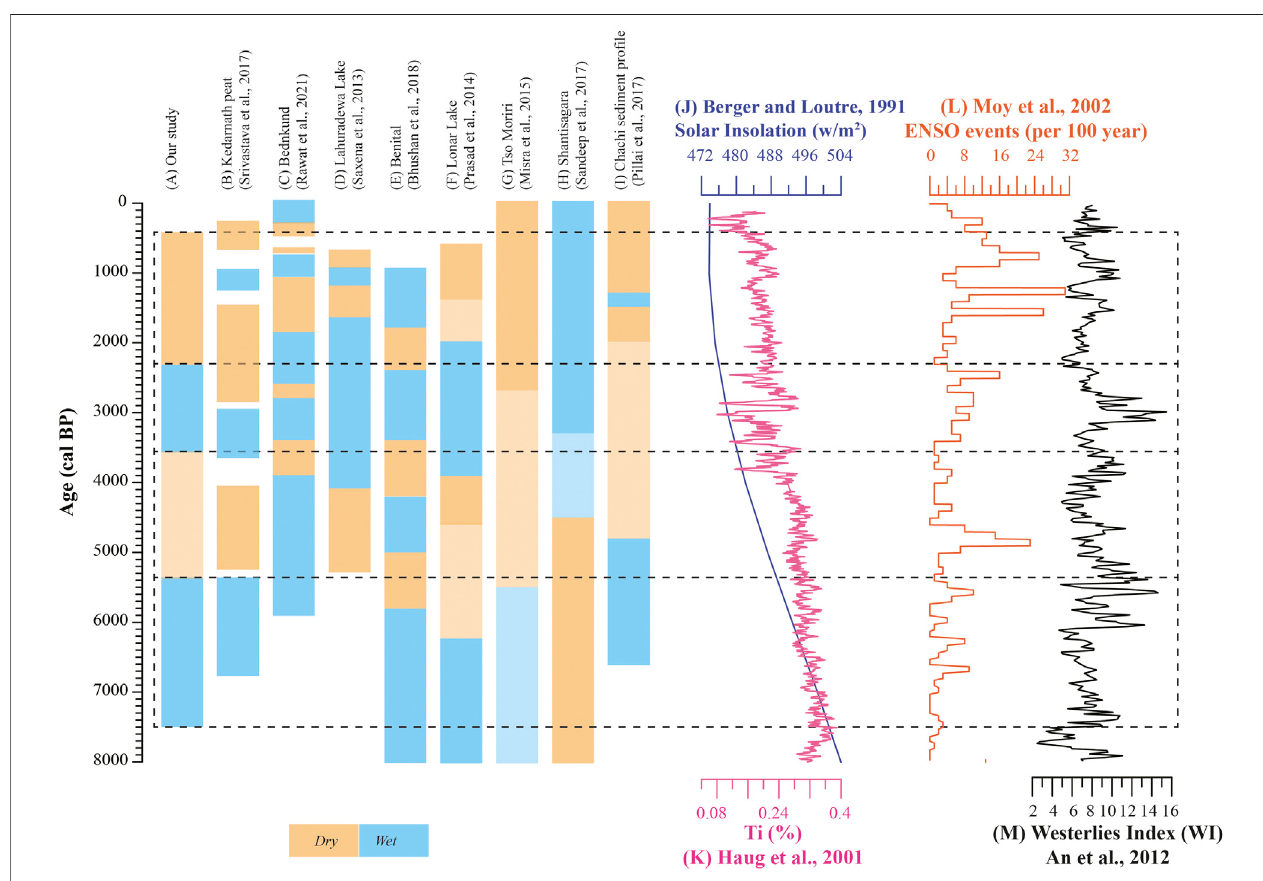
FIGURE 8 | Regional comparison of palaeoclimate data (A – I) with major teleconnections (J – M) .